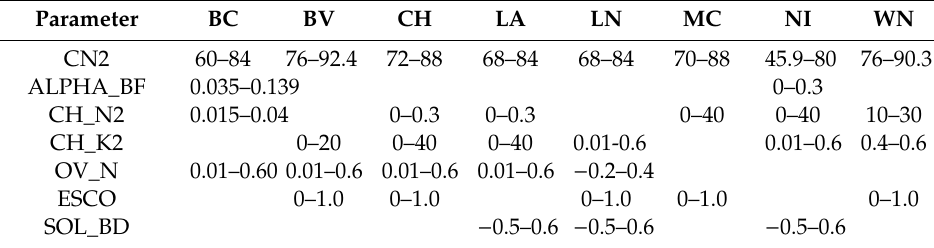
Table 6. IT_Q SWAT ranges for parameters that are variable and HSP.